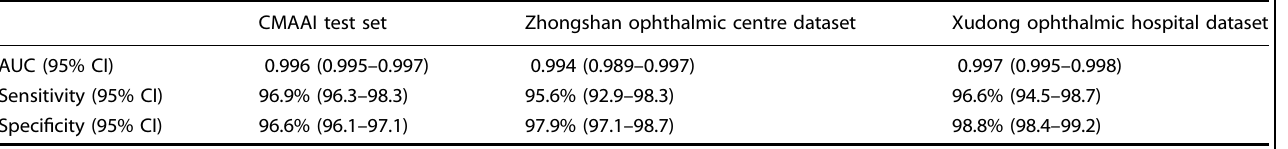
Table 1. Performance of the DLIFS in detecting poor-quality images. CMAAI test set